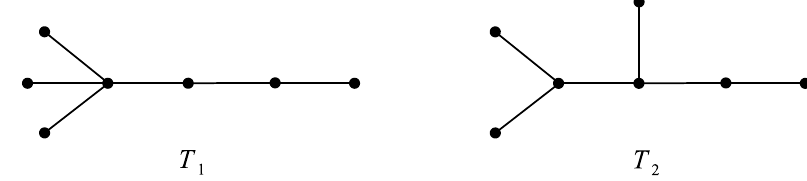
Figure 2. Trees T 1 and T 2 with equal SMP